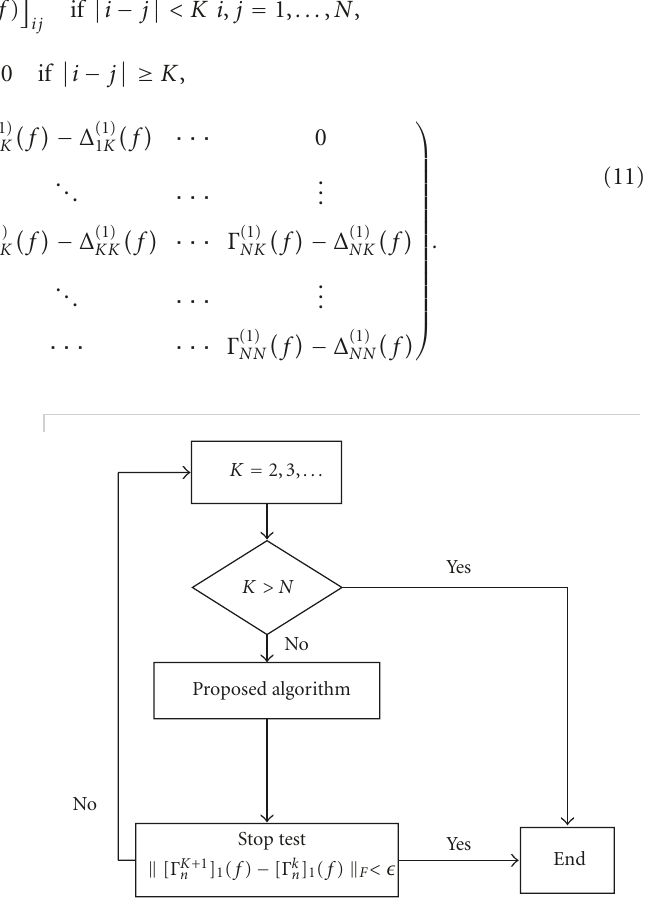
Figure 2: Integration of the choice of K in the algorithm, where ]( f ) indicates the principal diagonal of the banded noise [ Γ K n covariance matrix Γ n ( f ) with spatial correlation length K